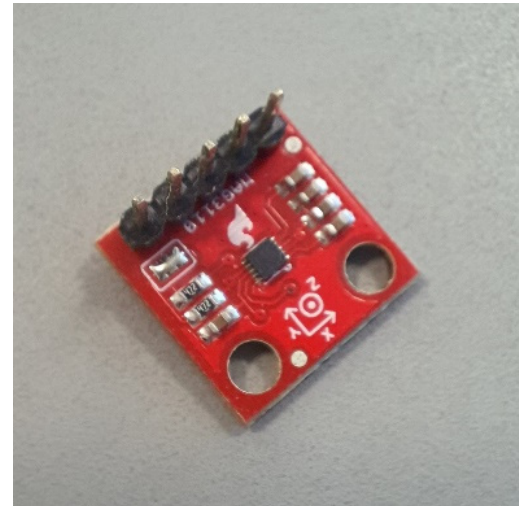
Figure 7. MAG3110 magnetometer.